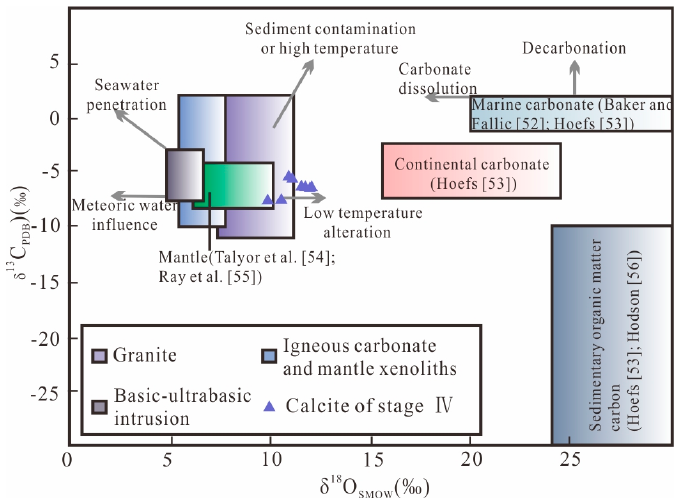
Figure 11. The δ 13 C PDB - δ 18 O SMOW diagram of the Chuduoqu Pb-Zn-Cu deposit (base map